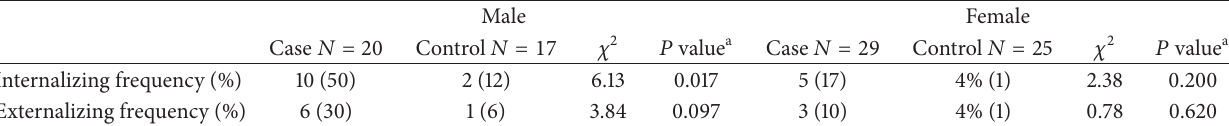
Table 4: Proportions of CAH patients with clinical range scores on internalizing and externalizing scales compared to the controls.